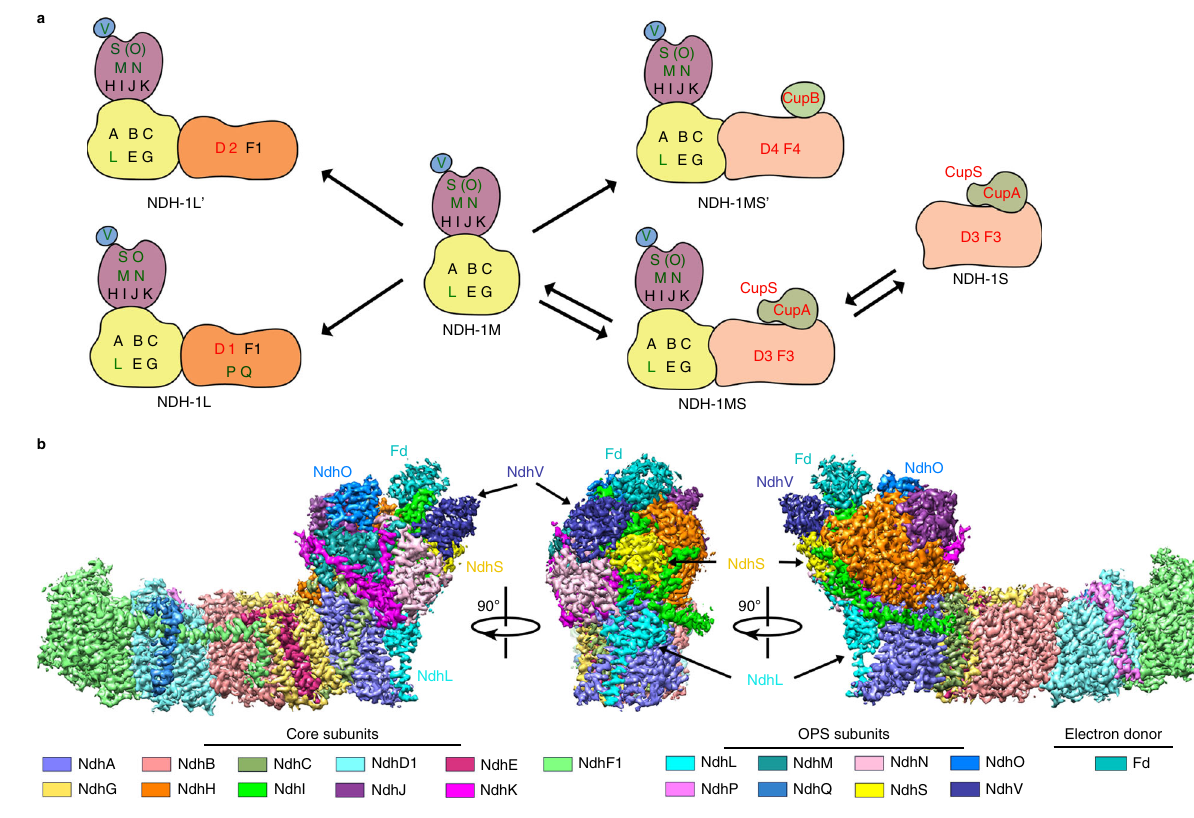
Fig. 1 Cryo-EM structure of the Fd-NDH-1L complex. a Subunit compositions of four types of cyanobacterial NDH-1 complexes, all of which share a common NDH-1M module. Subunits are labeled and colored; core subunits in black, OPS subunits in green and isoform-speci fi c subunits in red. NdhV is drawn as a separate subunit to emphasize that it transiently associates with the NDH-1 complexes. b Three views of the overall cryo-EM reconstruction of the Fd-NDH-1L complex. The cryo-EM density map is segmented by subunits of NDH-1L. Subunits of NDH-1L and Fd are color-coded and the scheme is shown